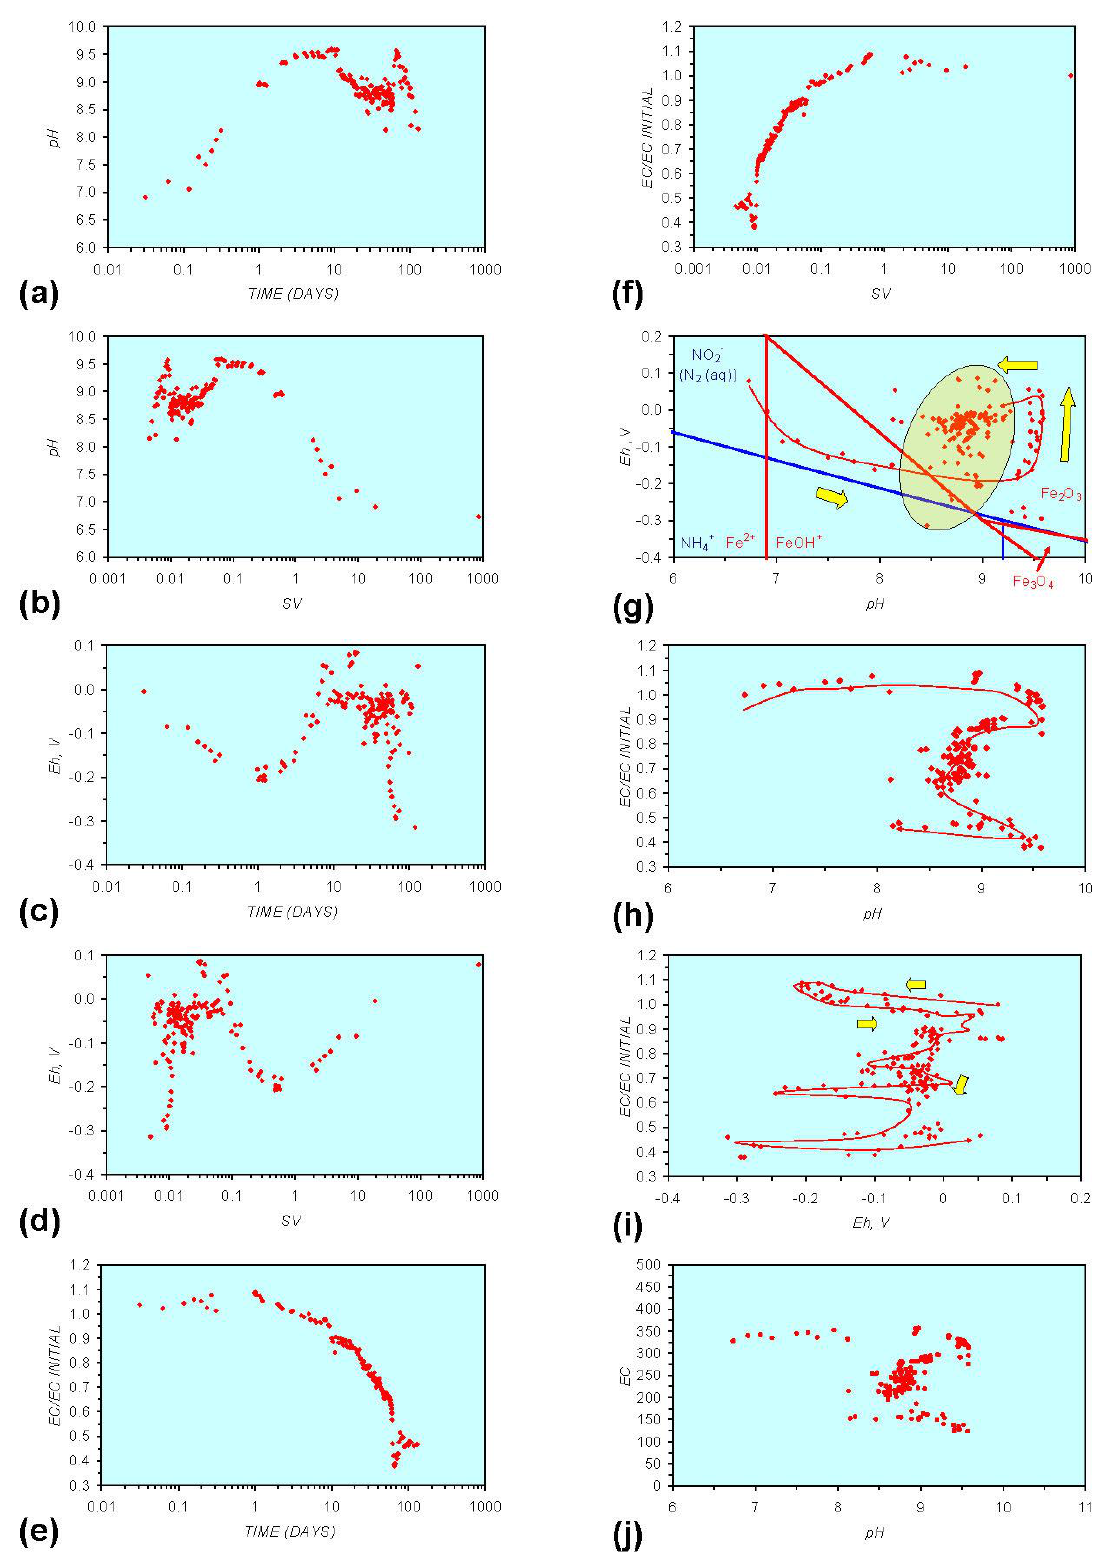
Figure A4. MR4: n-Fe 0 + n-Al 0 , fresh water. (a) pH vs. Time; (b) pH vs. SV; (c) Eh vs. time; (d) Eh vs. SV; (e) EC/EC Initial vs. time; (f) EC/EC Initial vs. SV; (g) Eh vs. pH (SRE ringed); (h) pH vs. EC/EC Initial; (i) Eh vs. EC/EC Initial; (j) pH vs. E(C) Arrows indicate decreasing SV and increasing